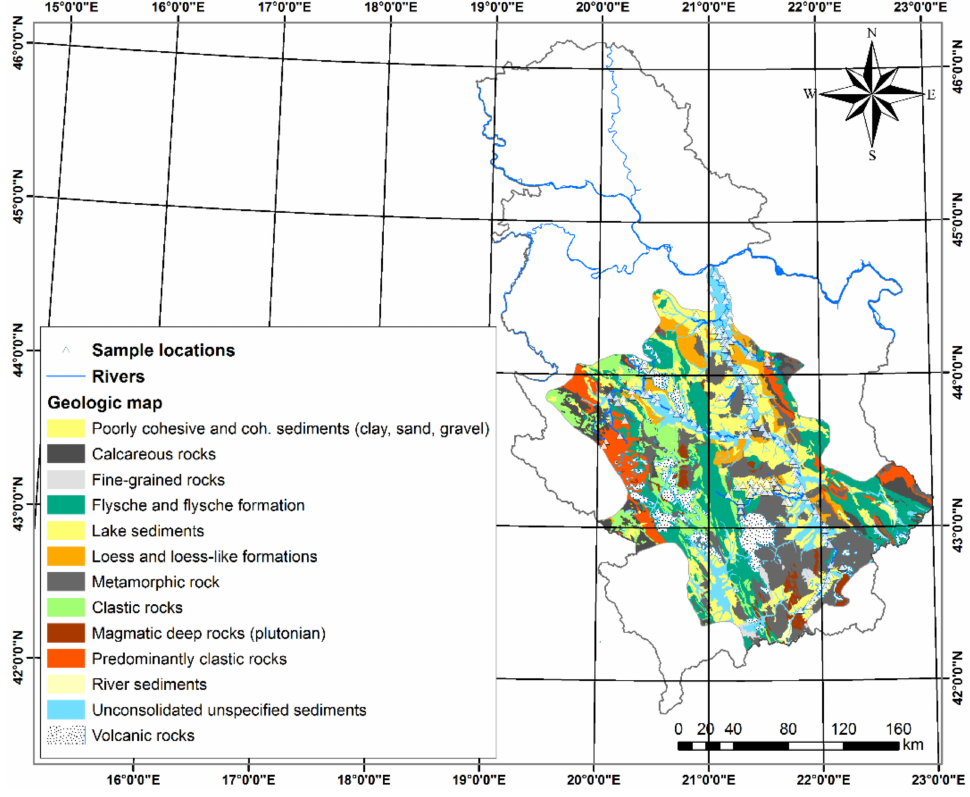
Figure 2. Geological map of the study